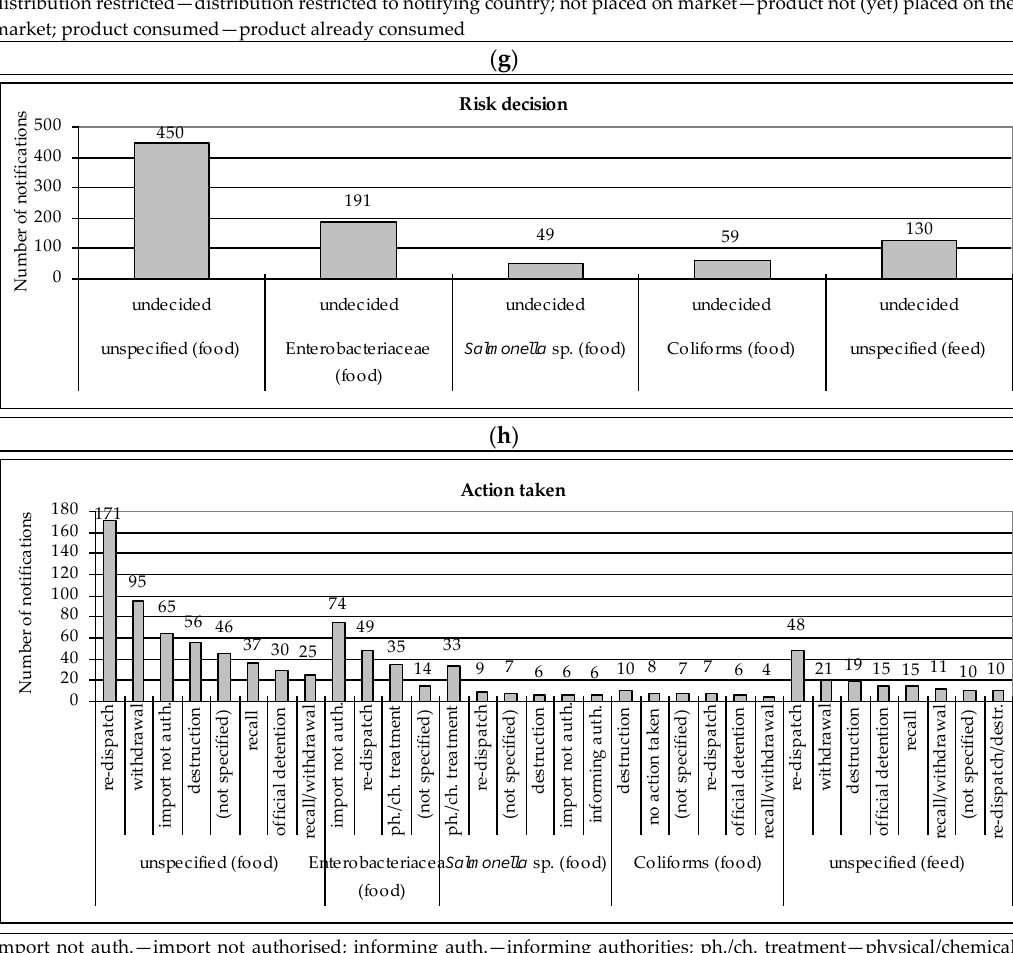
Figure 2. The numbers of RASFF notifications of non-pathogenic microorganisms in food and feed: ( a ) Year; ( b ) Product categories; ( c ) Notifying country; ( d ) Origin country; ( e ) Notification basis; ( f ) Notification type; ( g ) Distribution status; ( h ) Risk decision; ( i ) Action taken. Source: own study on the basis of [4].